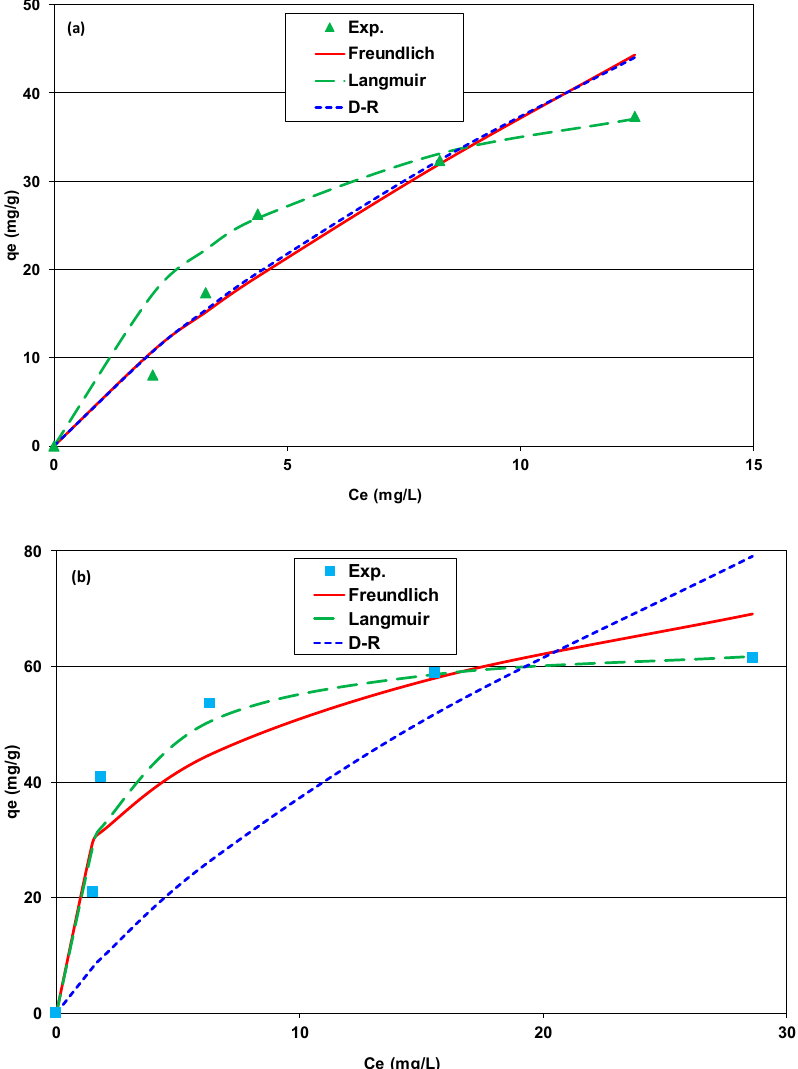
Figure 7. MB adsorption isotherms of IS-R ( a ) and IS-KOH-B ( b ): Experimental and fitted data with Freundlich, Langmuir, and D-R models (pH0 = 6.8; D = 1 g L − 1; t = 3 h; T = 20 ± 2 °C).